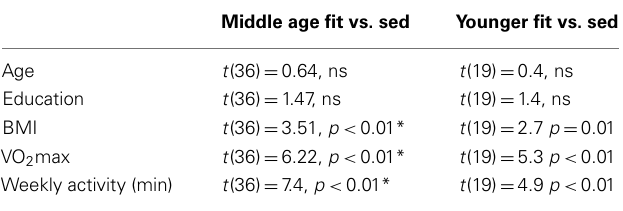
Table 4 | Fitness group